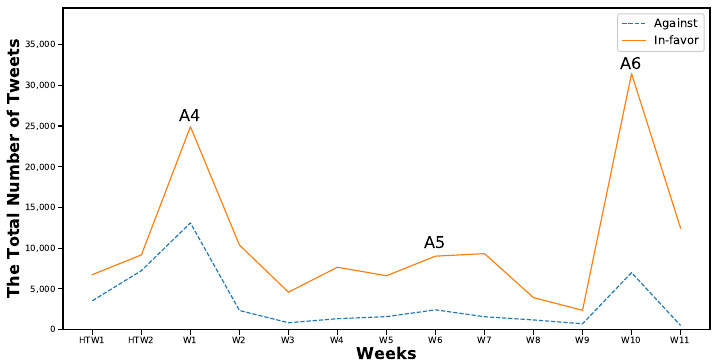
Figure 6. Cumulative weekly cleaned tweets for the second semester of the 2020 academic year. I calculated the percentage of tweets expressing In-favor and Against stances for a particular event from its announcement day until the next event (Figures 7 and 8). The highest percentage of In-favor stance tweets was recorded for event A1, reaching 86.8% in the first semester; this was followed by event A6, reaching 85.5% in the second semester. In contrast, the lowest percentage of In-favor stance tweets of 59.7% was recorded during the two-week half-term holiday, followed by event A4, which reached